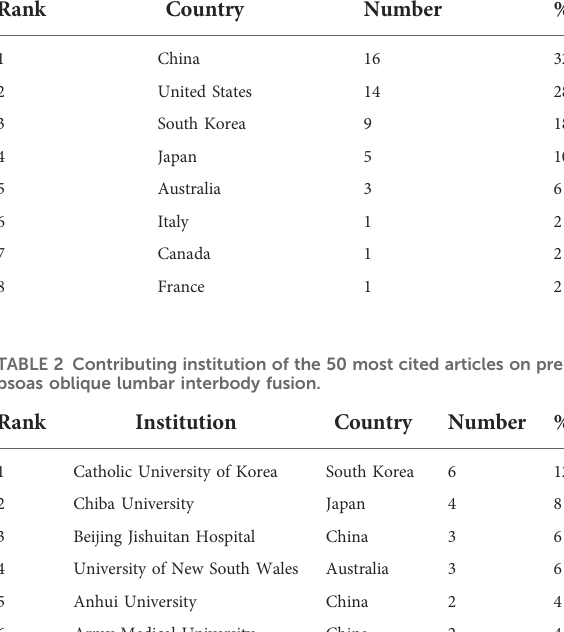
TABLE 1 Countries of the 50 most cited articles on pre-psoas oblique lumbar interbody fusion. Rank Country